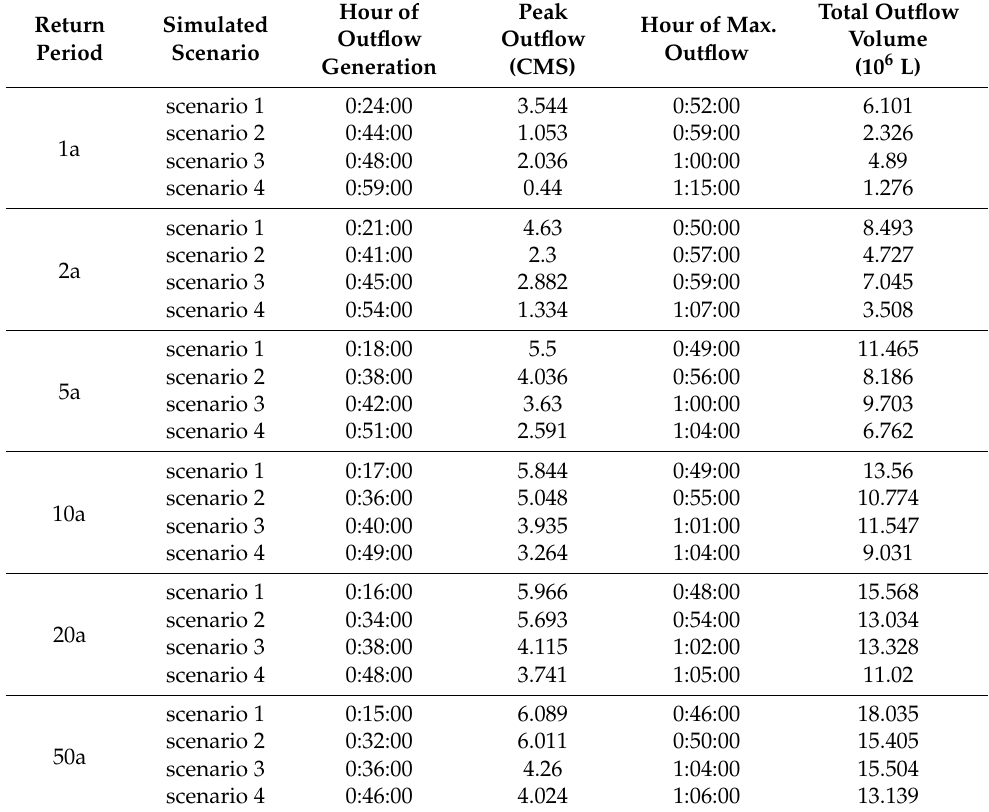
Table 4. The simulation of outfall in different